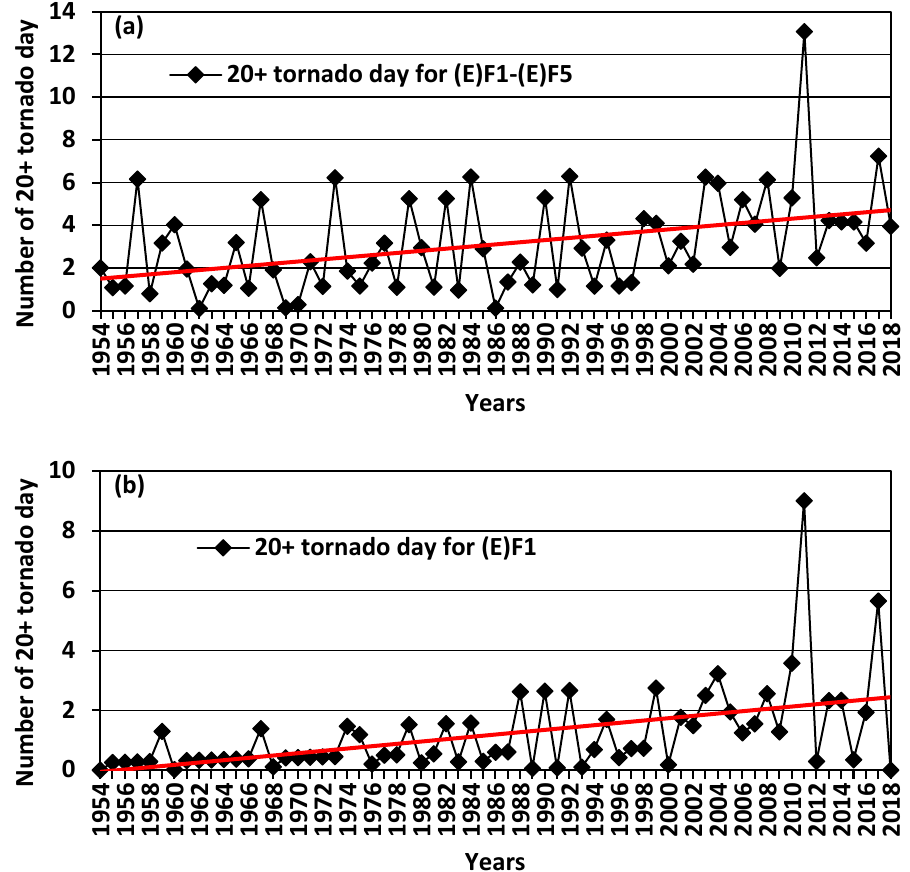
Figure 8. Number of 20+ tornado days (1954–2018) and its trend after removing AR(1) for ( a ) sum. of (E)F1 to (E)F5 tornado days and ( b ) (E)F1 tornado day.